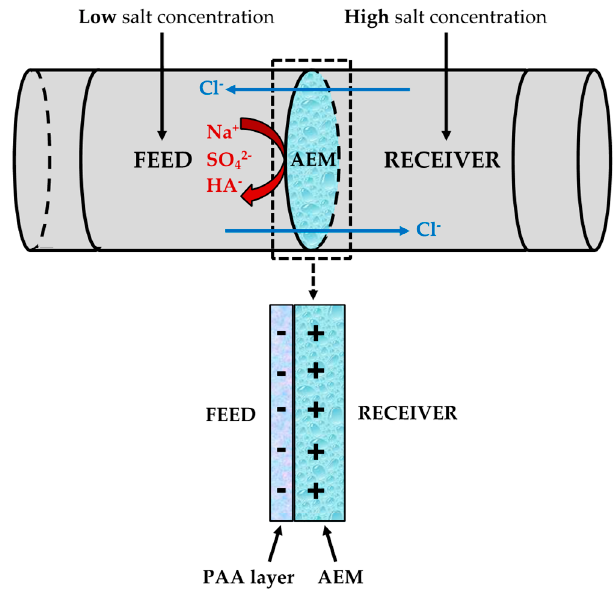
Figure 2. Two-compartment diffusion cell layout.